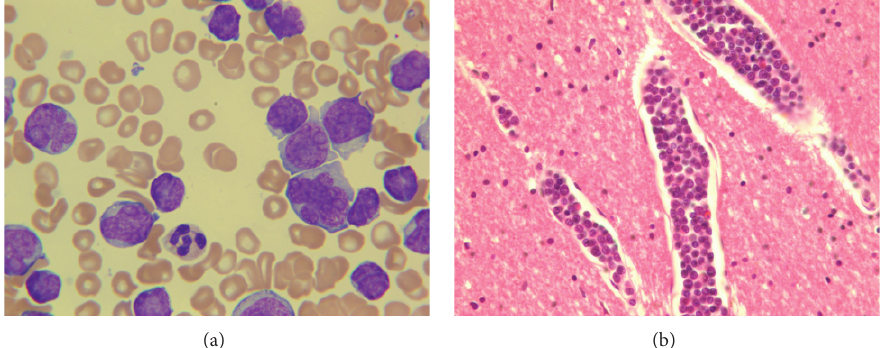
Figure 1: (a) Peripheral blood film demonstrating prolymphocytic population. (b) Representative vessels engorged by leukemic cells. Cerebrum, H&E stain, 400×